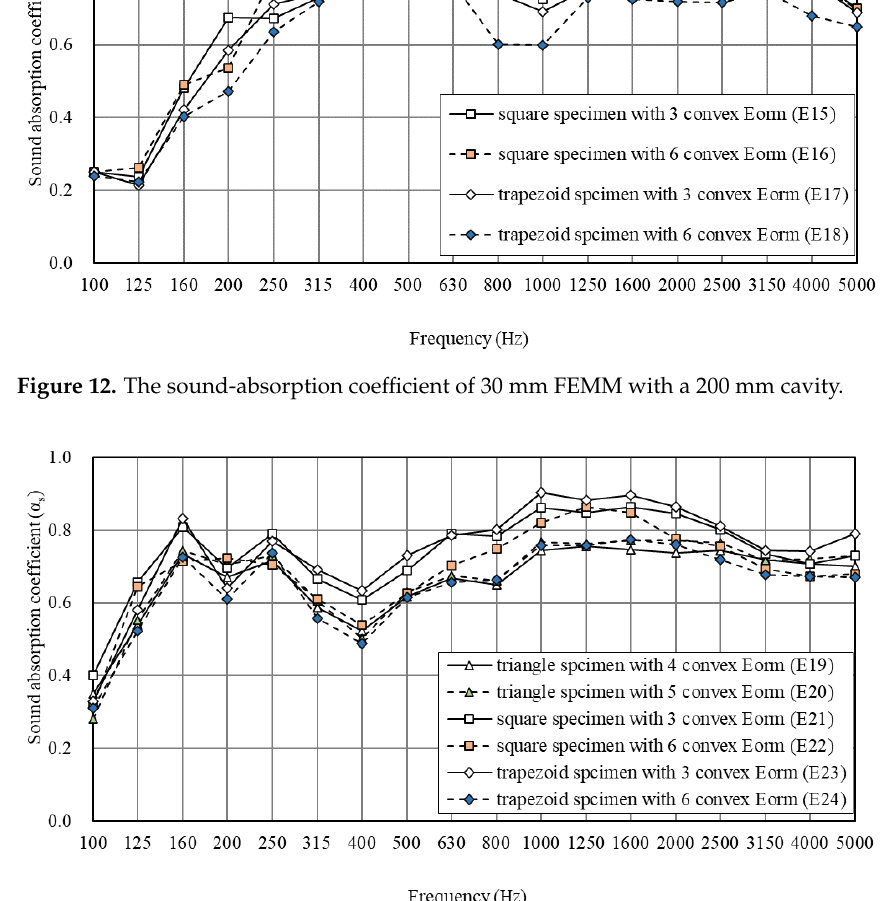
Figure 13. The sound-absorption coefficient of 55 mm FEMM with a 450 mm cavity.